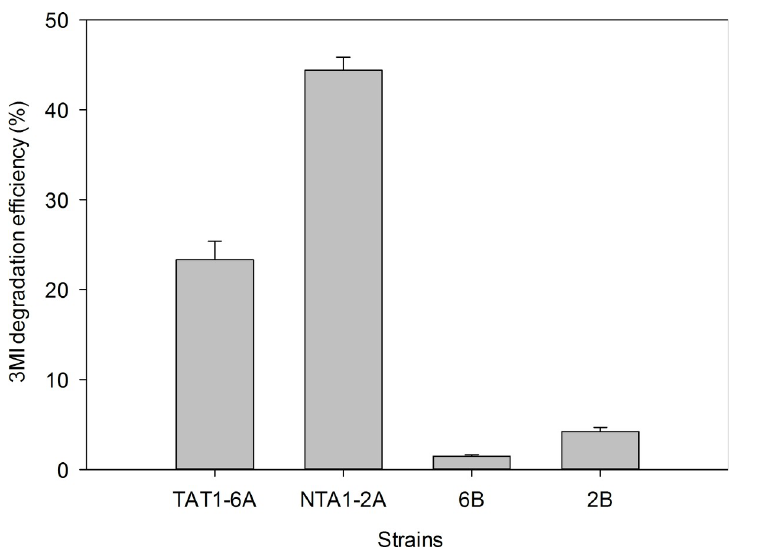
Fig 1. 3MI degradation efficiency of the different strains from chicken manure.